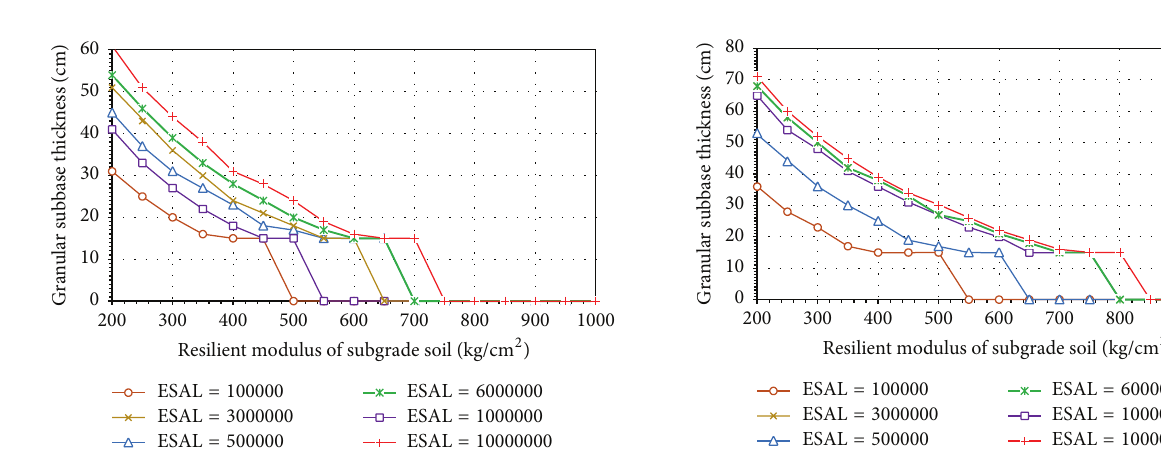
Figure 10: Optimal design thickness of granular subbase for expressways and